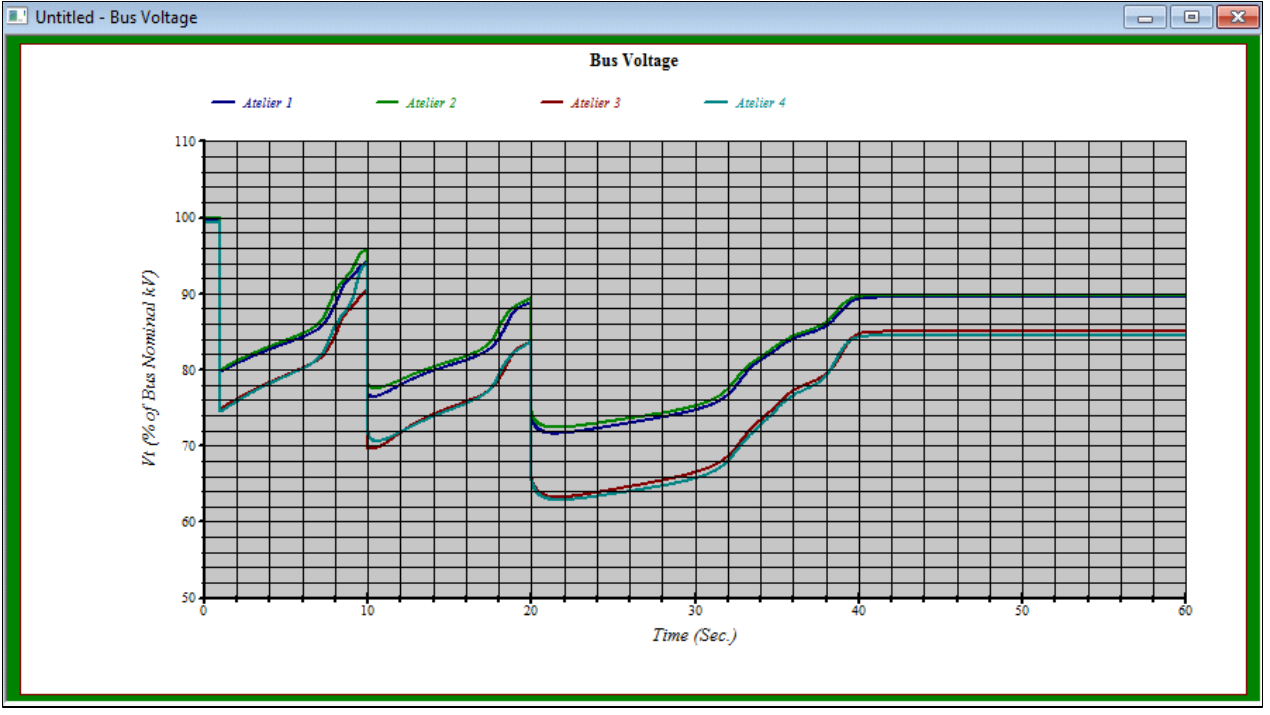
Figure 17: The Voltage level after start time delay. Source: Authors,